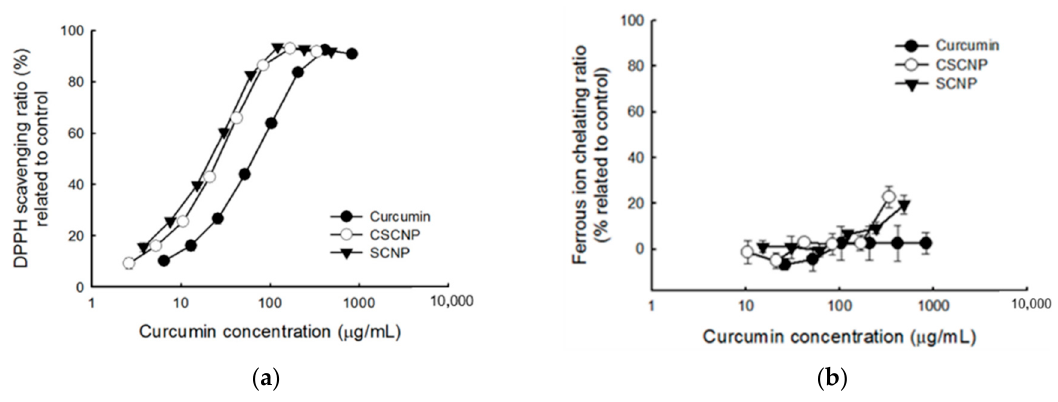
Figure 2. Antioxidant activities of curcumin, SCNP, and CSCNP. ( a ) DPPH scavenging activity and ( b ) ferrous ion chelating activity of curcumin, SCNP and CSCNP. Data were shown by mean ± standard deviation (SD) of 3 independent experiments ( n = 3) with 3 technical replicates. DPPH: 2,